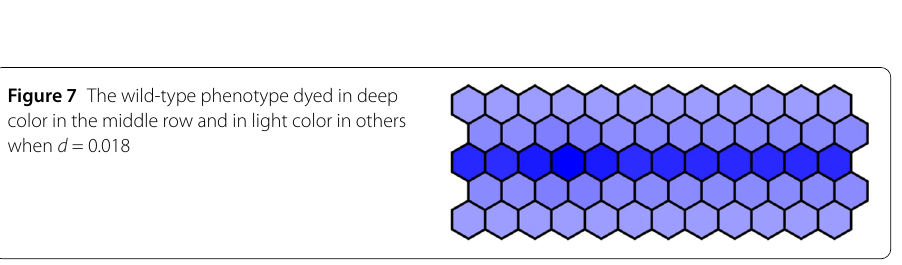
Figure 7 The wild-type phenotype dyed in deep color in the middle row and in light color in others when d =